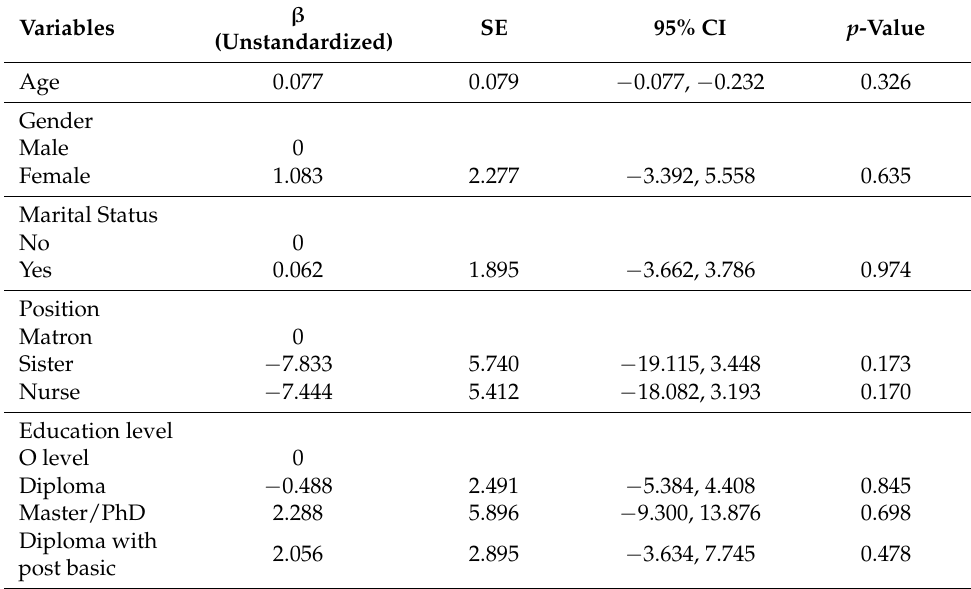
Table 3. Factors associated with self-reported HH performance using simple linear regression analysis ( n =